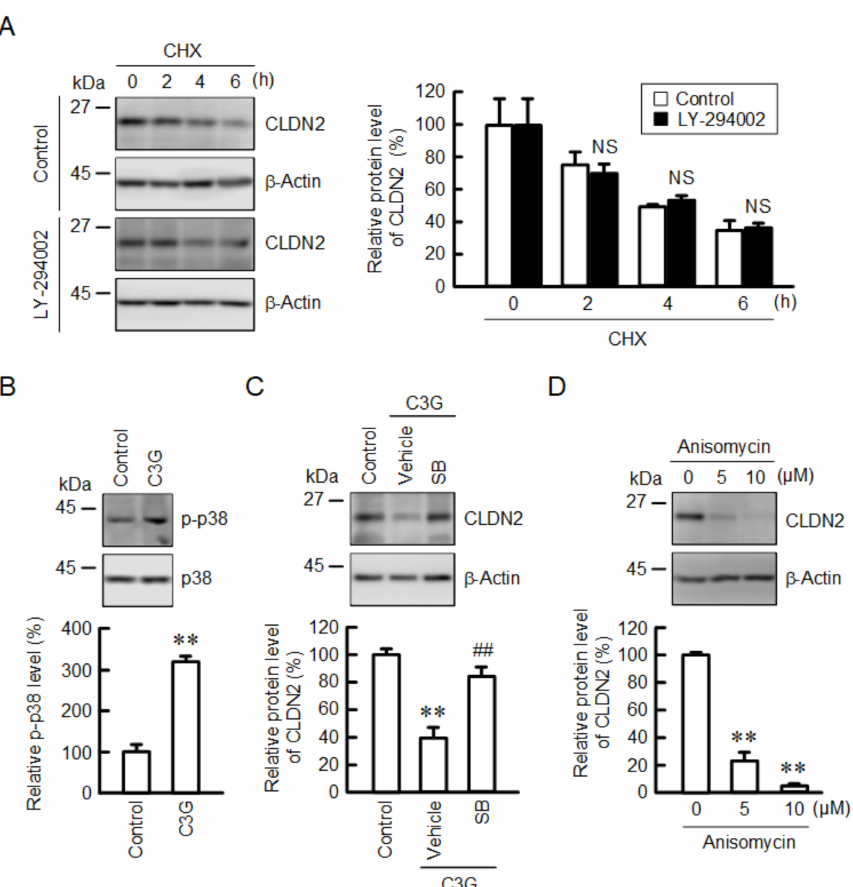
Figure 7. Effect of C3G on the levels of p-p38 and CLDN2. ( A ) Cells were incubated with 10 µ M CHX in the absence (control) and presence of 10 µ M LY-294002 for 0, 2, 4, and 6 h. Cell lysates were immunoblotted with anti-CLDN2 and anti- β -actin antibodies. The protein levels of CLDN2 are represented as a percentage relative to 0 h. ( B ) Cells were incubated in the absence and presence of 50 µ M C3G for 1 h. Cell lysates were immunoblotted with anti-p-p38 and anti-p38 antibodies. The p- p38 levels are represented as a percentage relative to control. ( C ) Cells were incubated in the absence and presence of 50 µ M C3G and 10 µ M SB203580 (SB) for 24 h. Cell lysates were immunoblotted with anti-CLDN2 and anti- β -actin antibodies. The protein levels are represented as a percentage relative to control. ( D ) Cells were incubated with 0, 5, and 10 µ M anisomycin for 24 h. Cell lysates were immunoblotted with anti-CLDN2 and anti- β -actin antibodies. The protein levels are represented as a percentage relative to 0 µ M. n = 3–4. ** p < 0.01 and NS p > 0.05 compared with control. ## p < 0.01 compared with